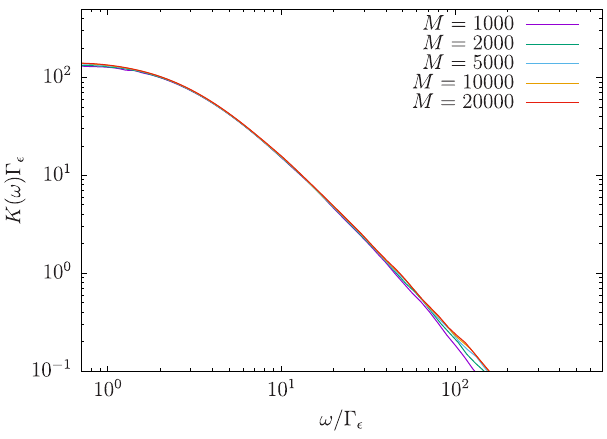
FIG. 25. The same as in Fig. 23 but with γ ¼ 1 . 8 and fitting exponent ε ¼ − 0 . 05 .